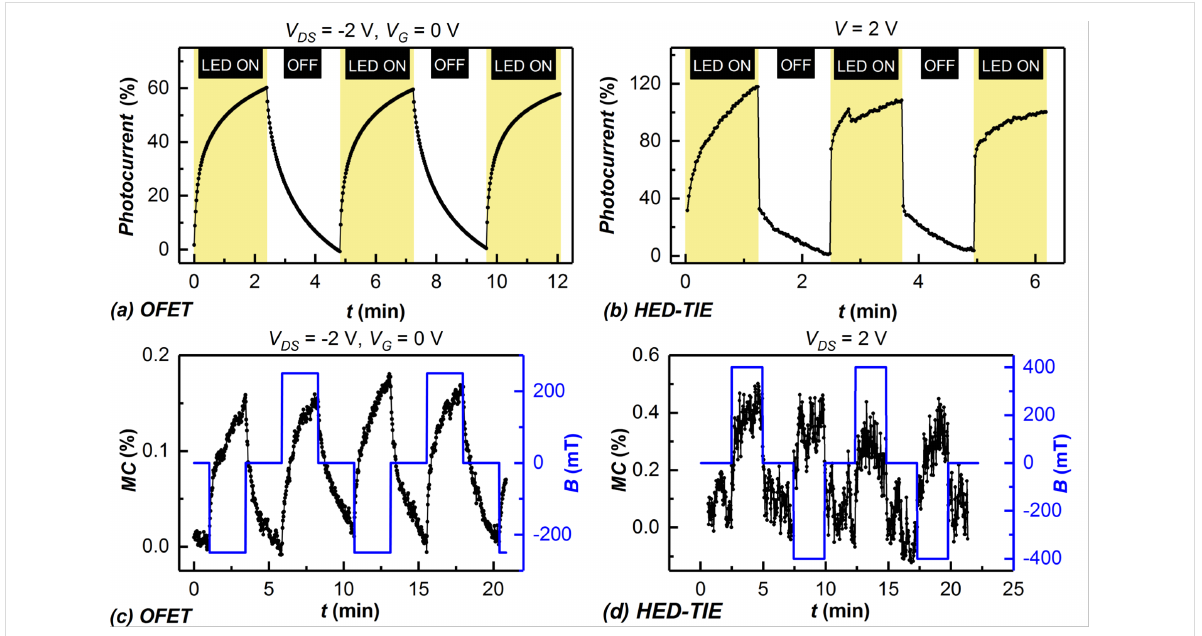
Figure 2: Light-switching behaviour of TIPS-pentacene-based (a) organic field-effect transistor (OFET) and (b) hybrid electronic device with trench- isolated electrodes (HED-TIE). Light-induced magnetoresistance in TIPS-pentacene obtained from both types of planar devices: (c) OFET and (d) HED-TIE